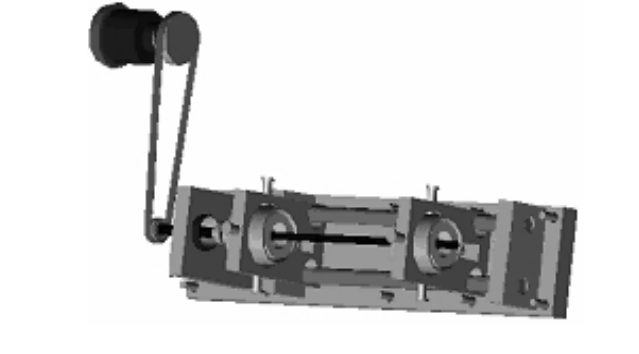
Fig. 1. The test rig.